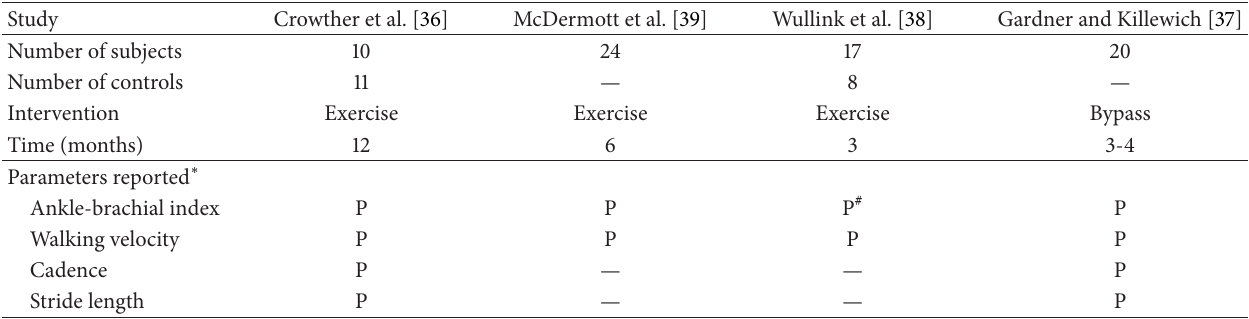
∗ Mean and standard deviation of the listed parameters were reported. # Postintervention measurements were not